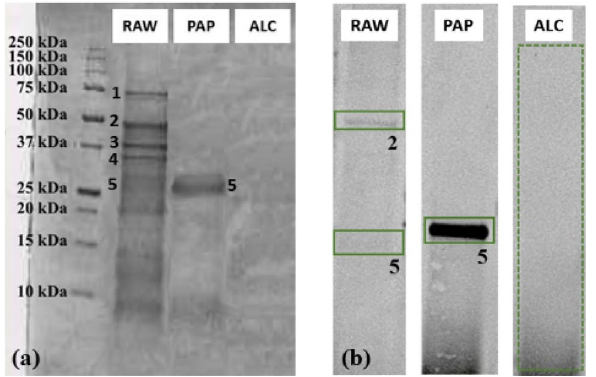
Figure 2. Green pea SDS–PAGE gel ( a ) and immunoblot performed on serum H ( b ) on green pea by-product protein extract (RAW) and enzymatic hydrolysates with papain (PAP) and alcalase (ALC). Equal numbers indicate equal proteins. Original blots/gels are presented in Supplementary figures S2 for gel and S10 B for blot serum